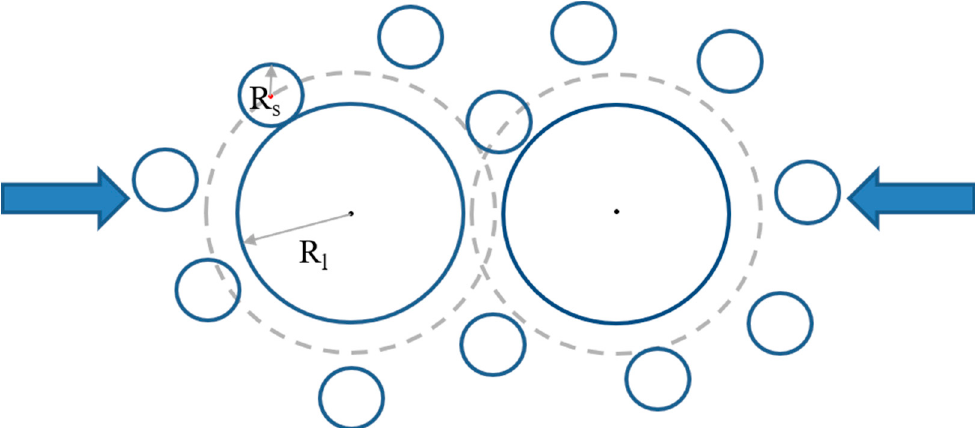
Figure 5 . Schematic illustration of depletion attraction between hard spheres. Small particles with radius R s is depleted form the large particle surface, large particle radius is R l . The ring around the large particle surface by dashed line is the depletion layer for small particles.